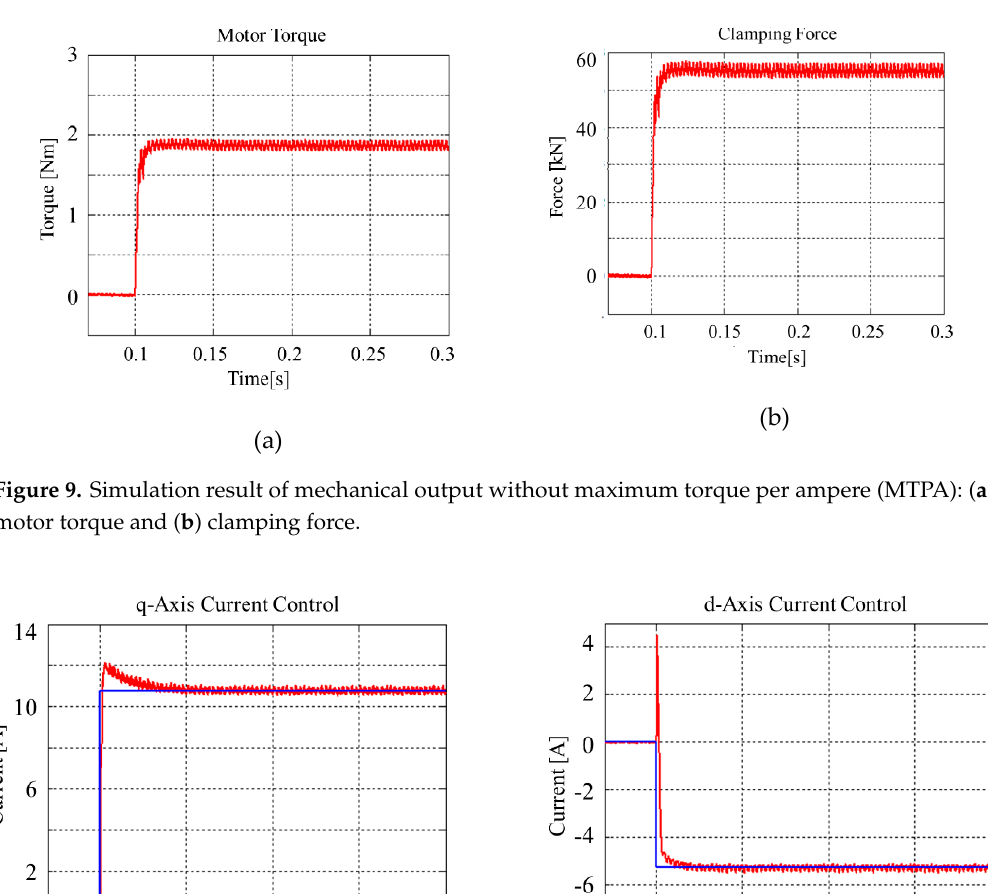
Figure 9. Simulation result of mechanical output without maximum torque per ampere (MTPA): ( a ) motor torque and ( b ) clamping force.